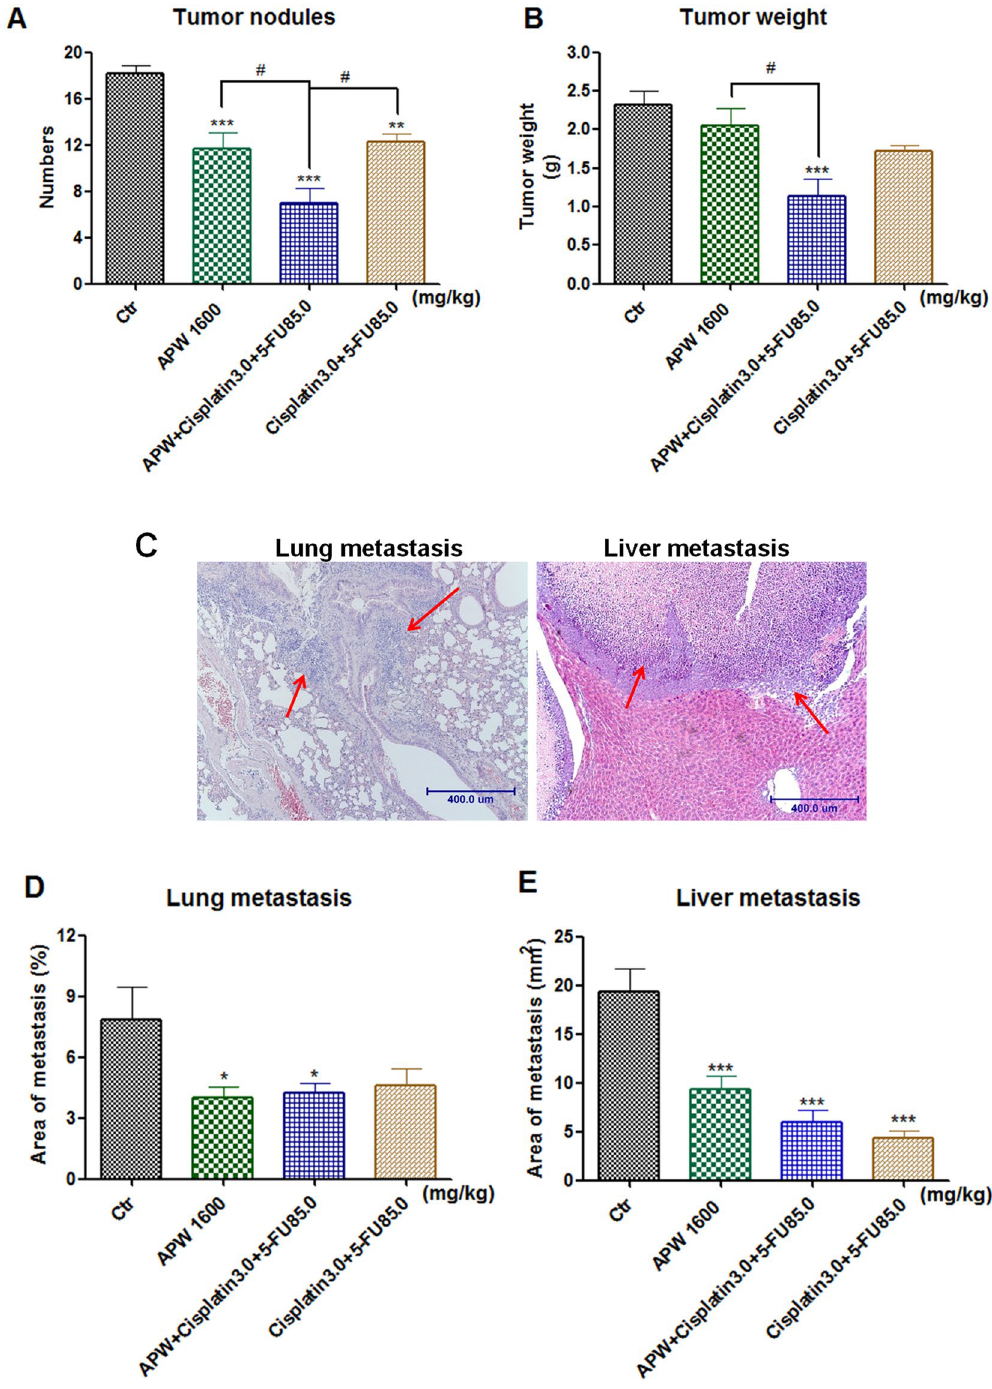
Figure 6. ( A and B ) The anti-tumor efficacies and ( C – E ) anti-metastatic effects of APW alone, the combination of cisplatin and 5-FU and the combination of APW, cisplatin and 5-FU in EC-109 intraperitoneal xenograft- bearing nude mice. ( A ) The numbers of tumor nodules (diameter greater than 2 mm) were counted. ( B ) All tumors collected from intraperitoneal cavity of each mouse were weight. ( C ) The representative photos of micro-metastasis in lungs and large nodules in liver with arrows showing the tumor cells. ( D ) The histograms represented the tumor burden in lungs as assessed by histological analysis, and expressed as an average percentage each group. ( E ) The histograms showed the tumor burden in liver, and expressed as an average tumor area per group in absolute units (mm 2 ). Data are expressed as the mean + S.E.M. (n = 10–13), * p < 0.05, ** p < 0.01, *** p < 0.001 as compared with control; # p < 0.05 as compared among treatment groups by one-way ANOVA followed by post-hoc Tukey’s multiple comparison